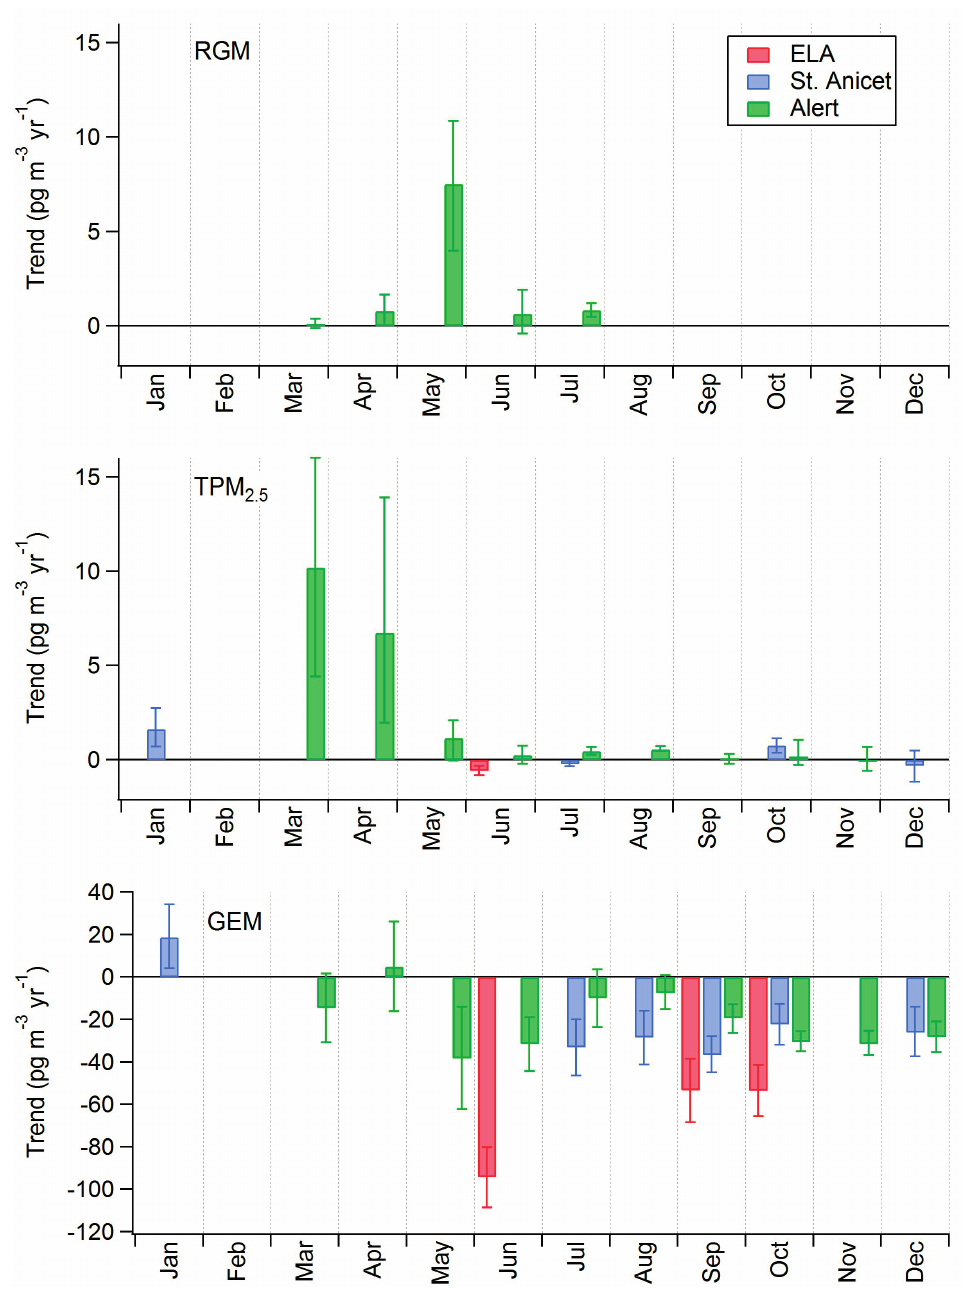
and GEM at the three sites with >5 years of Figure 12. Seasonal trends in RGM, TPM 2.5 speciation measurements. A positive trend indicates a year-over-year increase in concentrations for that month. Note scale change for